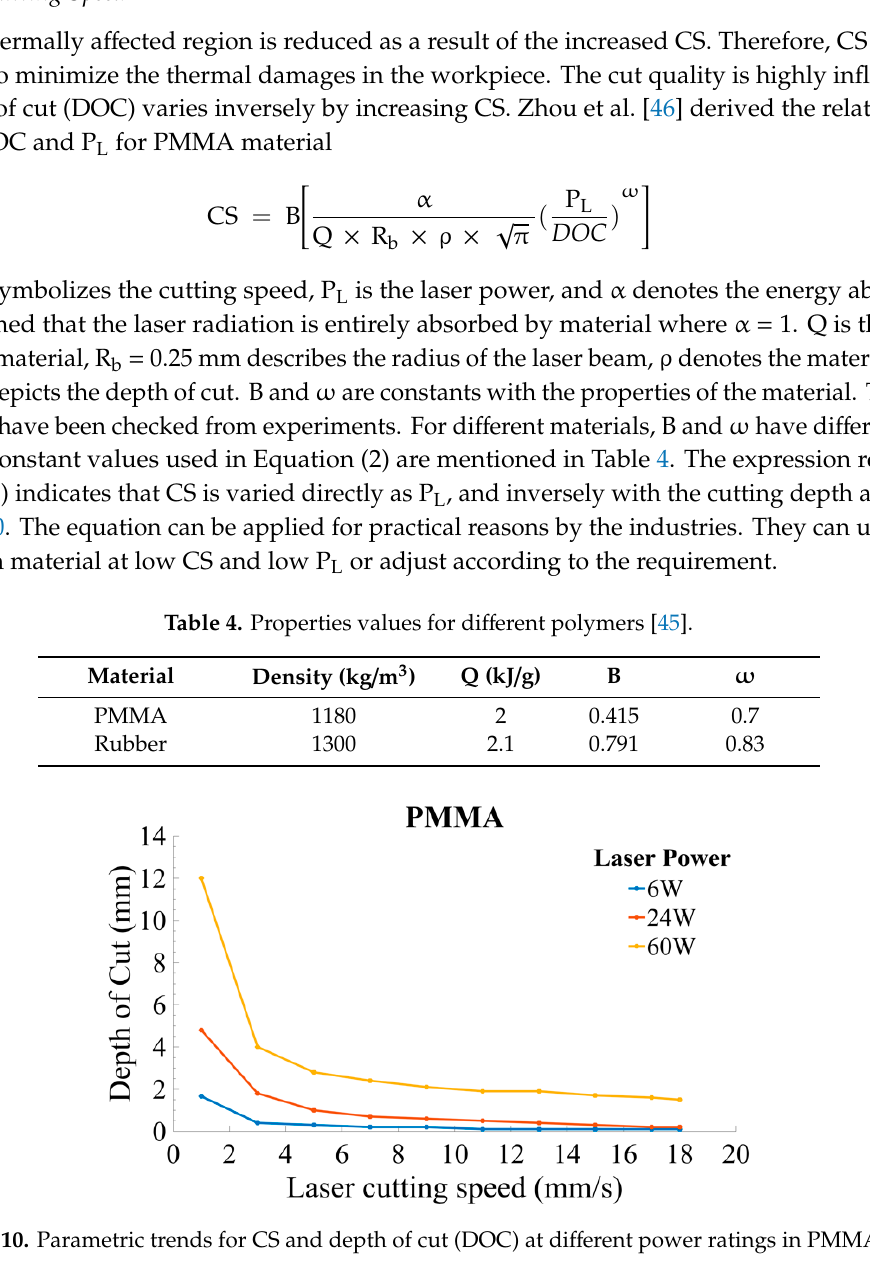
Figure 11. Parametric trends for CS and the thickness at different power ratings for PE and PP ( A ): Graphical trends for CS and thickness for PE at different power, ( B ): Illustration of steep curve to describe the relationship between CS and thickness, ( C ): Pictorial representation of PE cut part, ( D ): Graphical trends for CS and thickness for PE at different power, ( E ): Illustration of steep curve to describe the relationship between CS and thickness, and ( F ): Pictorial representation of PP cut part [8]. Parametric trends for CS and thickness for PE at different power ratings as depicted in Figure 11A. It can be seen that CS is inversely proportional to the work part thickness. Figure 11B indicated the pointed part of Figure 11A. The CS for PE material was set at 3.8 mm/s, P L of 300 W, along with the cutting thickness of 2 mm. The cut part is presented in Figure 11C. Figure 11D describes the parametric trends of CS and thickness for PP at various powers. Figure 11E indicated the pointed part of Figure 11D. The PP material with a 6 mm thickness was cut at 1.5 mm/s and 200 W P L . Figure 11F illustrates the pictorial view of the machined part. 1. Vishnulal et al. [47] performed an experimental investigation of CS, P L , and vibrational frequency (workpiece vibrations) for improving the laser cut quality in terms of MRR for PMMA, PC, and PP. The authors concluded that low-frequency vibrations ranging from 12 to 24